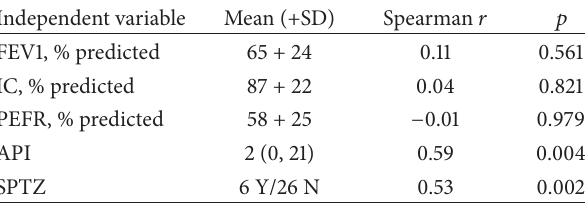
Table 3: Bivariate analysis, data obtained after treatment, when